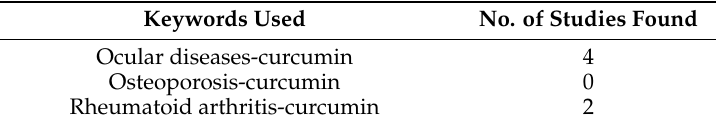
Table 5. Status of some of the major global clinical trials of curcumin in aging-associated diseases. ClinicalTrials.gov